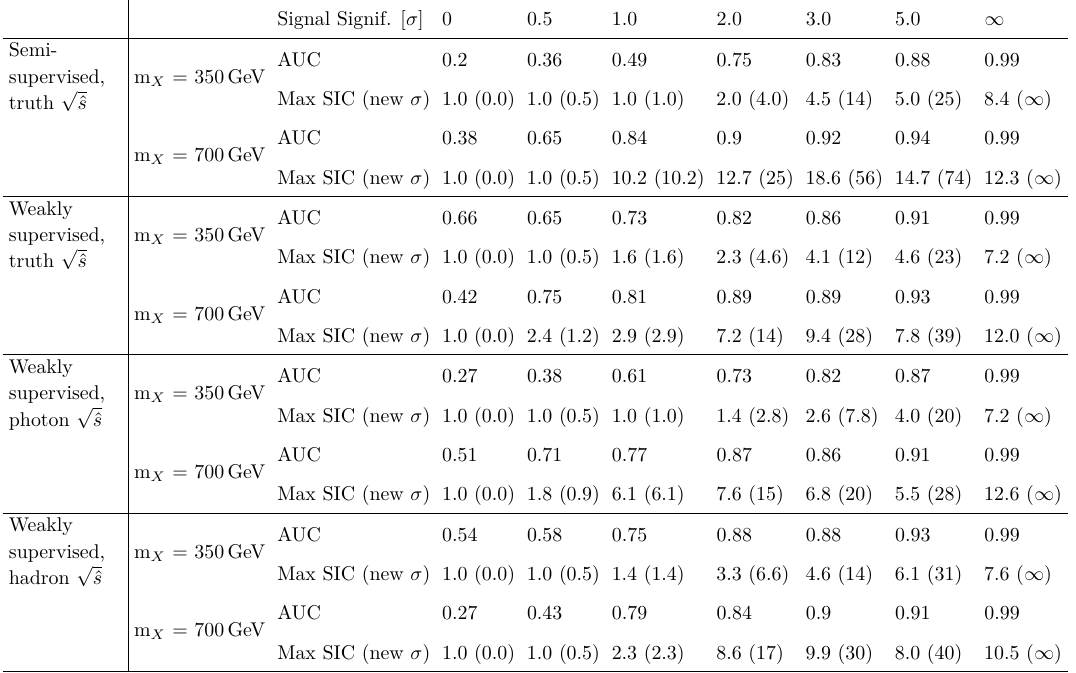
Table 3. Summary of all considered training scenarios, the resulting area-under-curve (AUC), and maximum value of the significance improvement characteristic (SIC) curve. A significance of ∞ indicates the case of pure signal versus pure background. The “new σ ” refers to the sensitivity of the signal excess after a neural net selection, which is dictated by the max SIC